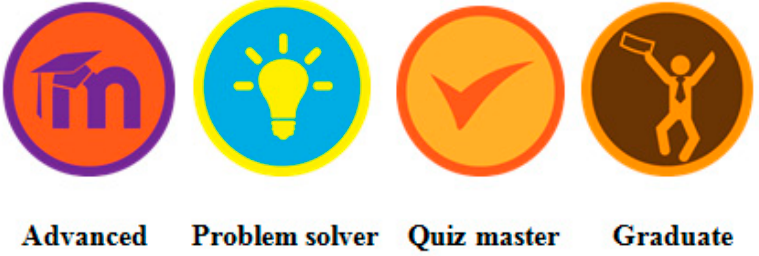
Figure 2. Examples of the badges used in the gamified course.